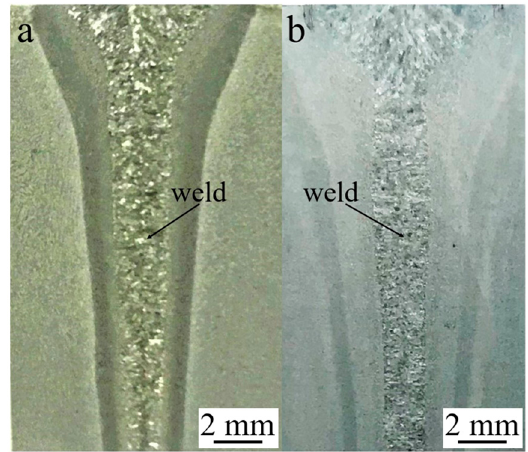
Figure 16. Microstructure of EBW joint. ( a ) Microstructure for one time welding. ( b ) Microstructure for pre-heating, welding and post-heating.